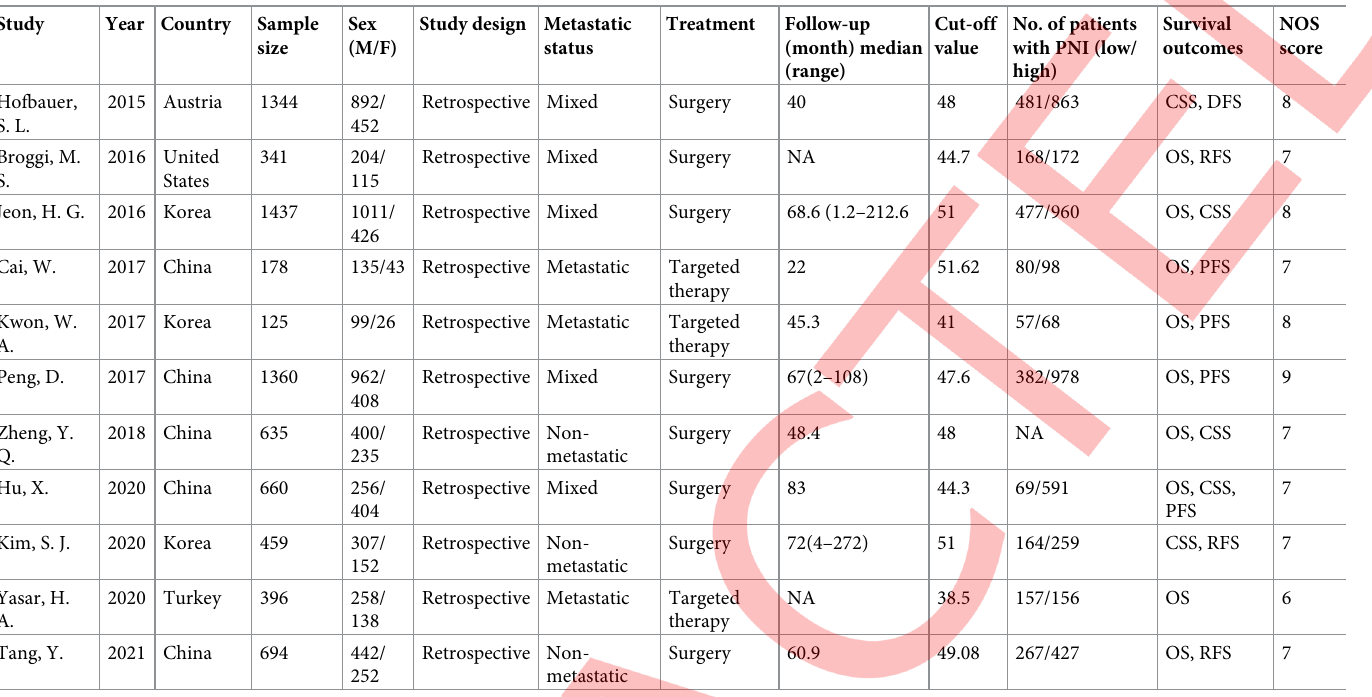
Table 1. Basic characteristics of included